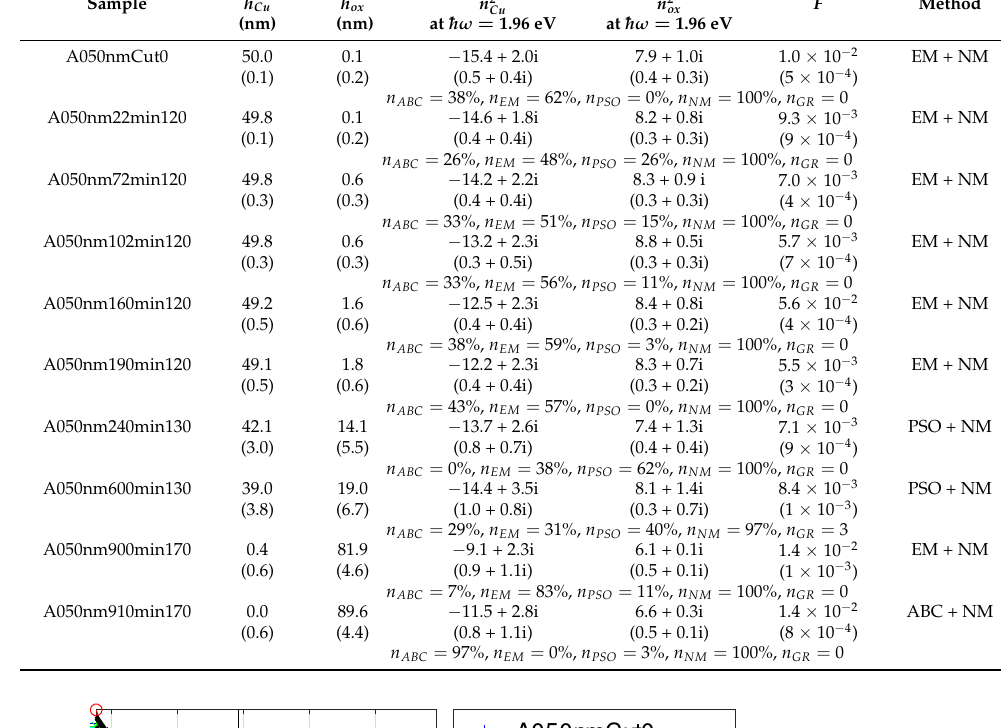
photon energies, the decrease in the real part is similar to that of the two previous samples. Table A5. The recovered thickness of copper and copper oxide, and the relative permittivity of copper and copper oxide at λ 0 = 632.8 nm, by fitting experimental UV-visible-NIR absorbance curves. The recovered relative permittivities can be compared to those of bulk copper and copper oxide, resp. − 11.55 + 1.57i and 8.64 + 0.64i [29]. The value of the multi-objective function F (Equation (A3)) and the most efficient metaheuristics are also indicated. Values between brackets are standard deviation for acceptable solutions, i.e., obtained for F below 25% threshold (for F ∈ [ min ( F ) ;1.25 × min ( F )] . The corresponding success of each metaheuristic is indicated in percentages).